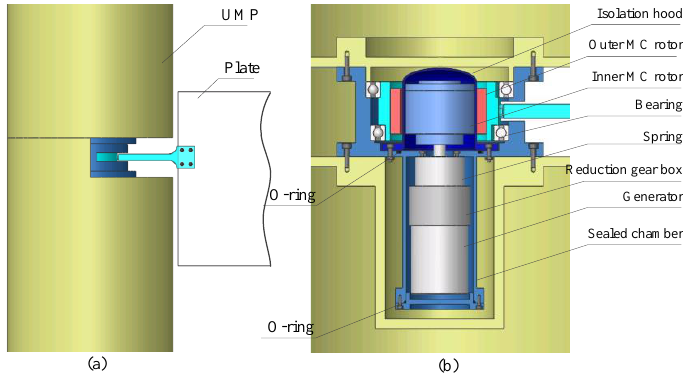
Figure 2. Components of the FIVEC: ( a ) general view and ( b ) inside